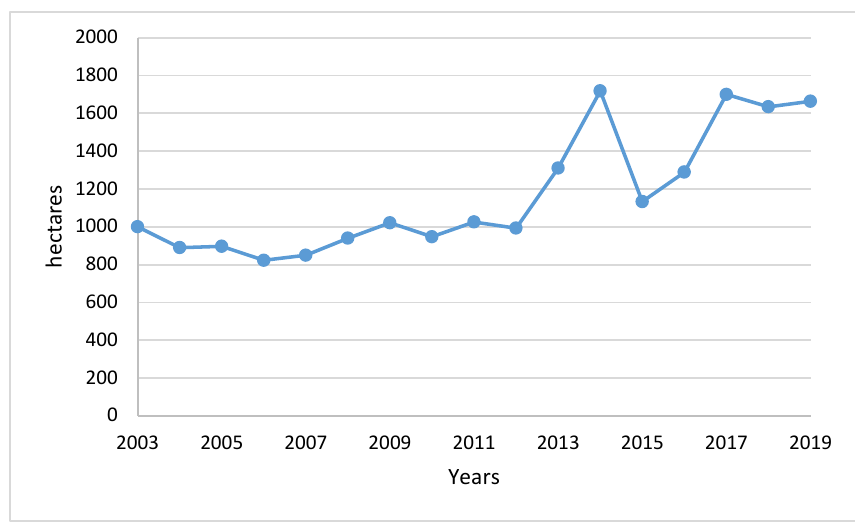
Fig. 1 . Cocaine price in